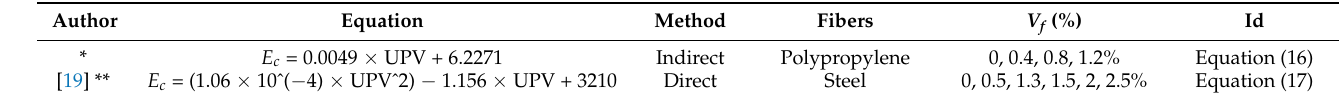
Table 7. Static modulus of elasticity prediction equations based on UPV.